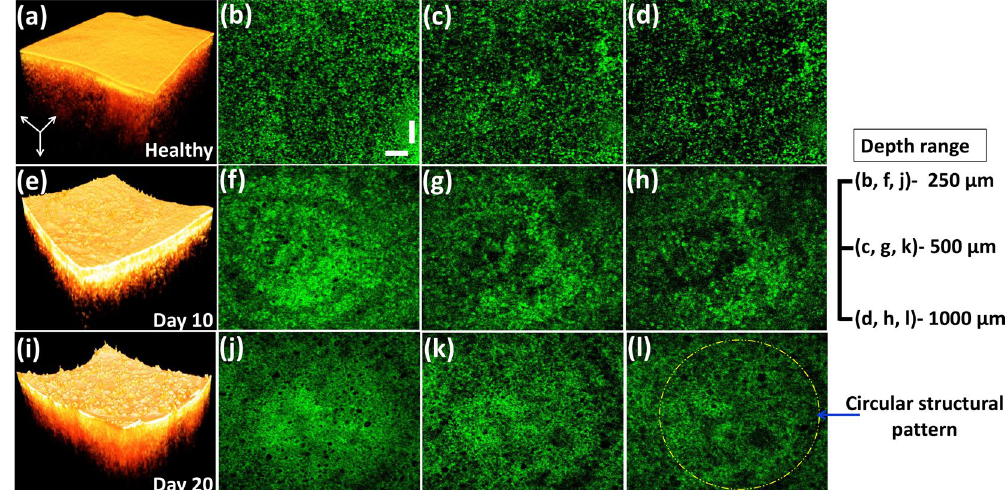
Figure 6. Illustration of the structures of a healthy specimen along the depth direction and structural differences according to the progress of the disease infection. The enface images were obtained from the corresponding depth levels of 250 μ m, 500 μ m, and 1000 μ m, from each specimen. The dashed yellow-colored circle depicts the formation and the spread of circular tissue patterns in infected regions. Vertical and horizontal scale bars, 500 μ